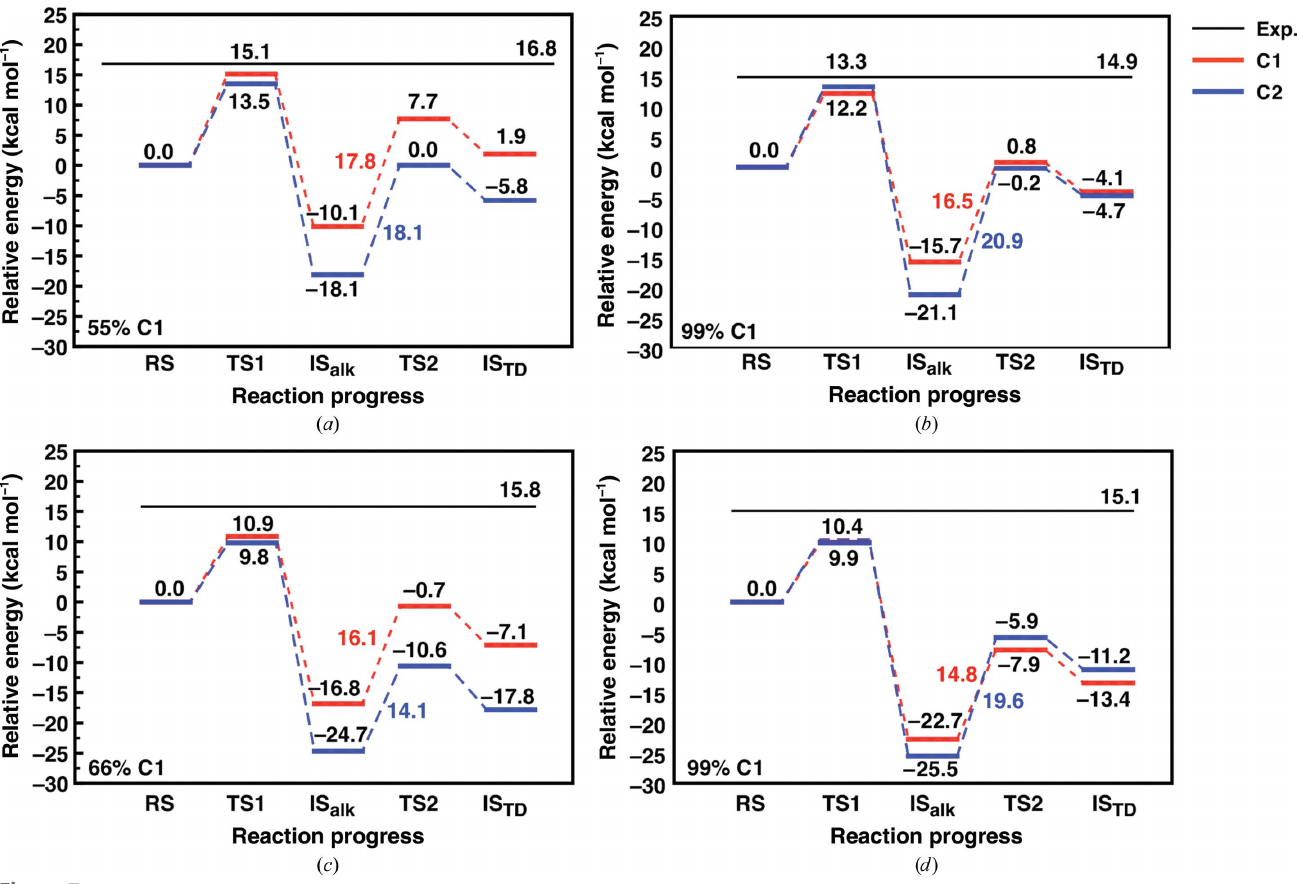
Figure 7 Calculated free-energy profiles for the StEH1-catalyzed hydrolysis of 1a bound in the preferred of the two binding modes shown in Fig. 2. RS, TS1, IS alk , TS2 and IS TD indicate the Michaelis complex, the transition state for nucleophilic attack on the epoxide, the alkylenzyme intermediate, the transition state for the hydrolysis of this intermediate and the resulting tetrahedral intermediate, respectively. All values are averages over 30 individual trajectories at each reacting state. Shown here are the reactions catalyzed by wild-type StEH1 ( a , b ) and R-C1 ( c , d ) for the ( R , R )-enantiomer ( a , c ) and the ( S , S )-enantiomer ( b , d ). The absolute energies for each reacting state are shown in black, and the relative energies for TS2 (relative to IS alk ) are shown in red and blue for attack on C1 and C2, respectively. Finally, the experimentally observed regioselectivity for each system is shown at the bottom left of each plot (see Table 1). The corresponding raw data are shown in Table 3 and bar charts of the activation free energies are shown in Fig.